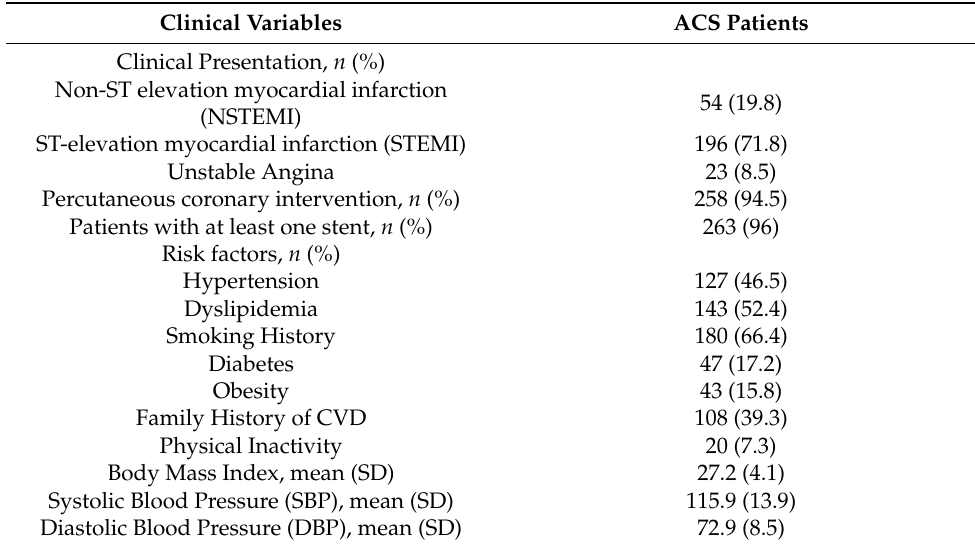
Table 2. Clinical characteristics of the sample ( N = 275). Frequencies ( n ) and percentages are reported for clinical presentation, percutaneous coronary intervention, patients with at least one stent, and risk factors. Means and standard deviations (SD) are reported for body mass index, systolic blood pressure, and diastolic blood